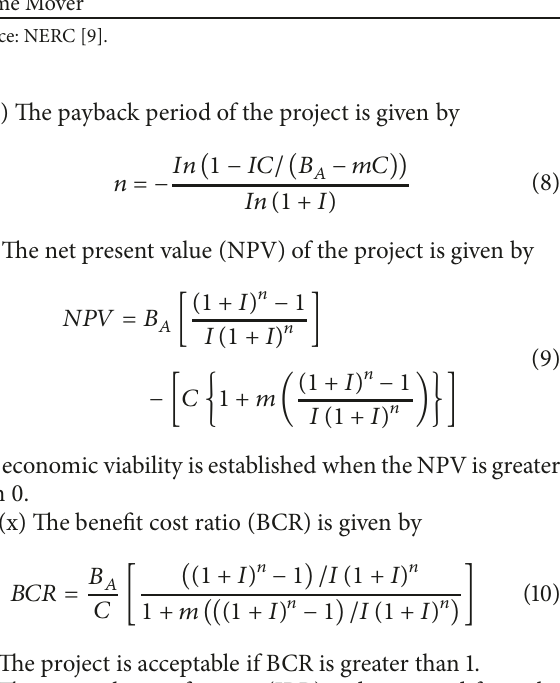
Table 14: Additional economic parameter for biomass gasification power